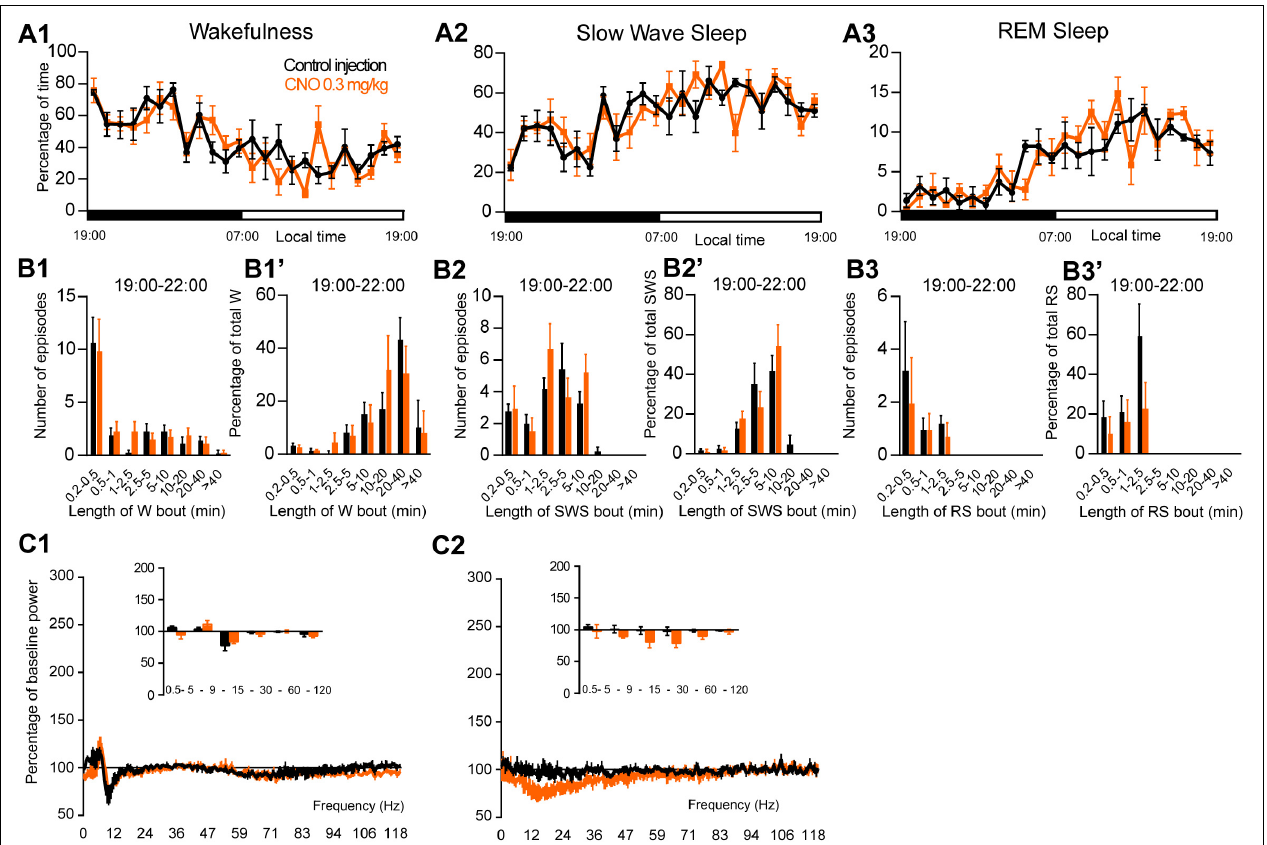
FIGURE 8 | Activation of PZ Phox2B-expressing neurons during the active period (19:00 or ZT12). (A) Hourly amount of wakefulness (A1) , SWS (A2) and REM sleep (A3) following CNO (0.3 mg/kg, N = 4 mice) as compared with control injection. (B1–B3) Number of episodes ( ± S.E.M.) of wakefulness (W), SWS or REM sleep (RS) in each bout length and (B1’–B3’) time-weighted frequency histograms showing the proportion ( ± S.E.M.) of W, SWS or RS amounts in each bout length as a percentage of the total amount of W, SWS or RS during the 3 h post-injection period (19:00–22:00; N = 4). (C1–C3) Sleep-wake power spectrum changes over baseline during the 3 h (19:00–22:00) post CNO (0.3 mg/kg, N = 3 mice) injection as compared with control injection; and the quantitative changes ( ± S.E.M.) in power for the δ (0.4–5 Hz), θ (5–9 Hz), α (9–15 Hz), β (15–30 Hz), low γ (30–60 Hz) and high γ (60–120 Hz) frequency bands ( ± S.E.M.) following vehicle or CNO (0.3 mg/kg, N = 3 mice) administrations. Power spectral analysis was not performed for REM sleep due to the low amount of this vigilance stage. Control injection in Black, CNO injection in orange; no significant change, two-way ANOVA followed by a post hoc Bonferroni